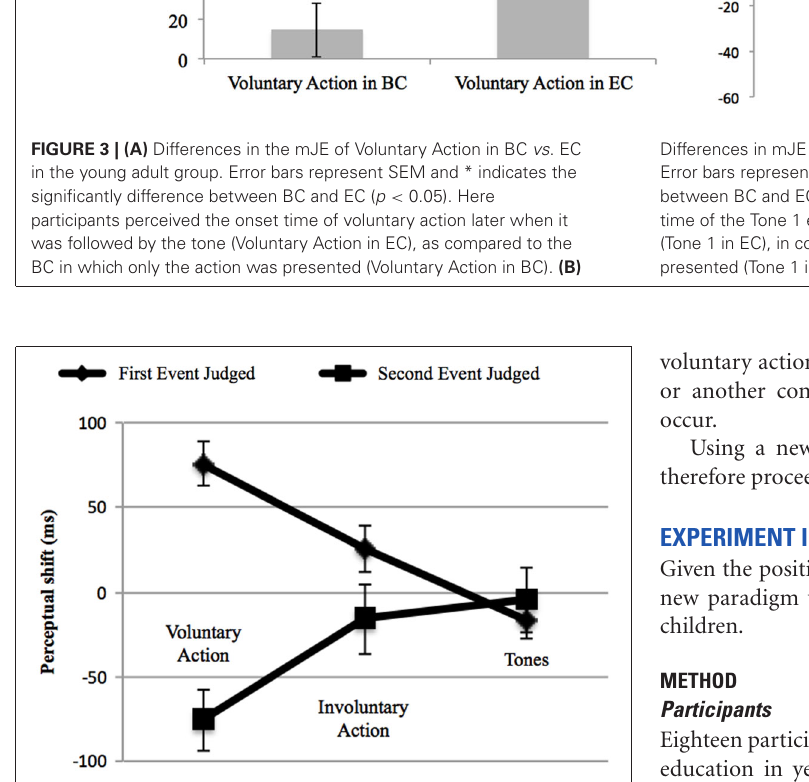
FIGURE 4 | Adults’ perceptual shifts in the three main contexts: Voluntary Action, Involuntary Action and Tones (i.e., the two auditory stimuli context: Tone 2–Tone 1) . Error bars represent SEM. The first event judged ( (cid:7) ) could be either the voluntary action, the involuntary action or the Tone 2. The second event judged ( (cid:4) ) was always represented by Tone 1. Negative perceptual shifts indicate than an event is perceived earlier in an experimental condition than in the baseline condition; positive perceptual shifts indicate that an event is perceived later in an experimental condition than in the baseline condition. Only voluntary actions produce IB (left). On the middle and on the right the involuntary action and two tones contexts are represented respectively, showing no